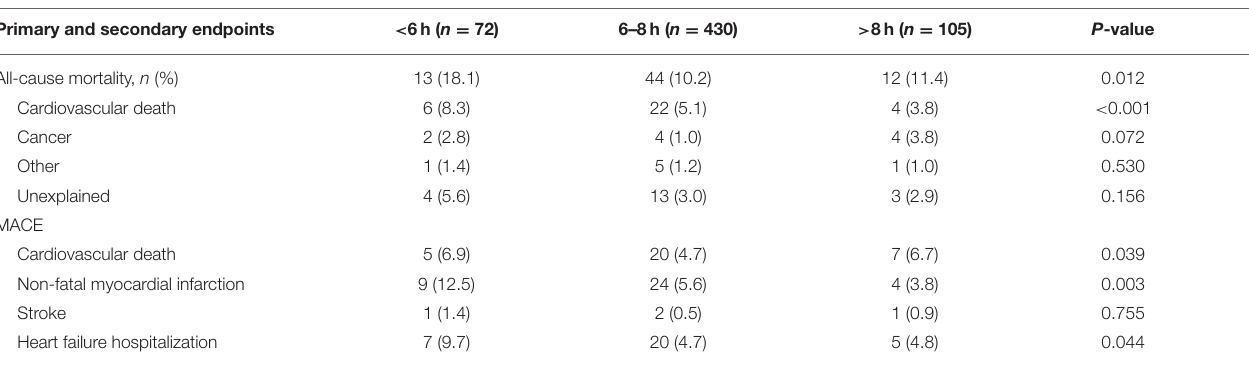
TABLE 3 | Major clinical outcomes of the study population during